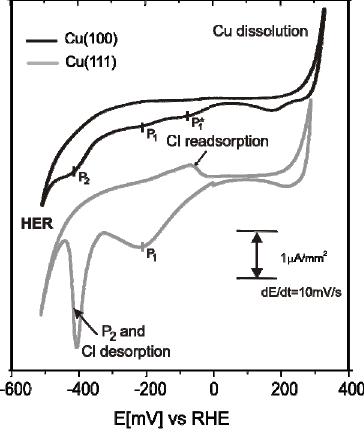
Figure 8. Cyclic voltammograms of Cu(100) (upper black curve) and Cu(111) (lower grey TTMAPP] 4+ cations (10 mM HCl + curve) electrodes in an electrolyte containing [H 2 TTMAPP). P /P indicate the stepwise reduction of the H 0.1 mM H * and P 2 1 1 2 molecules, d E /d t = 10